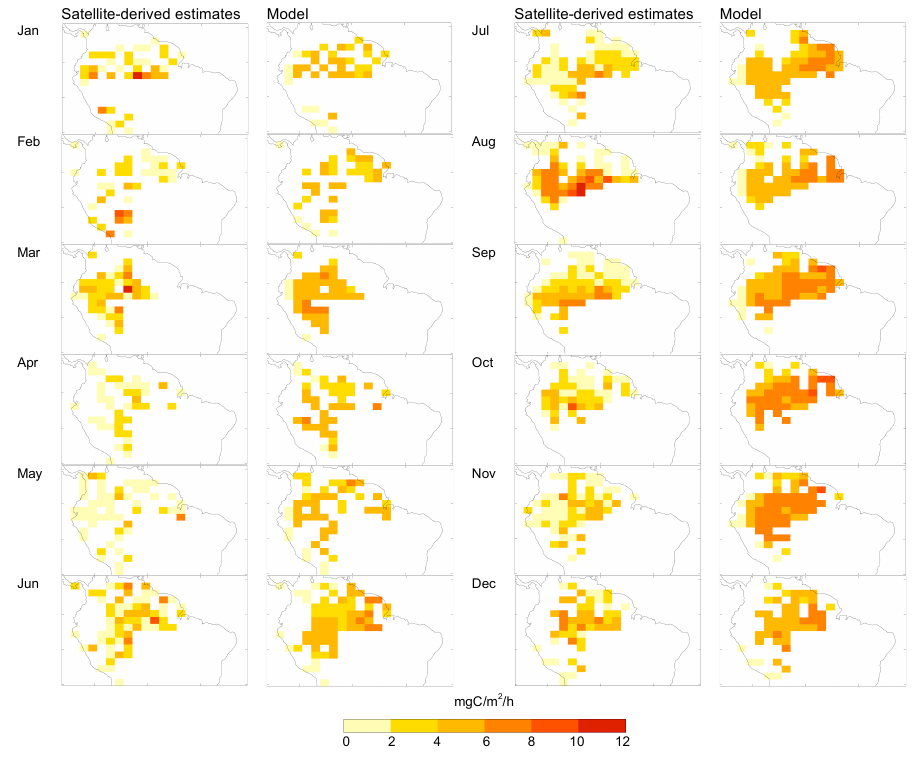
Fig. 8. Comparison of spatial patterns of simulated and satellite-derived monthly mean isoprene emissions (10:00–12:00LT) over tropical South America for 1999.